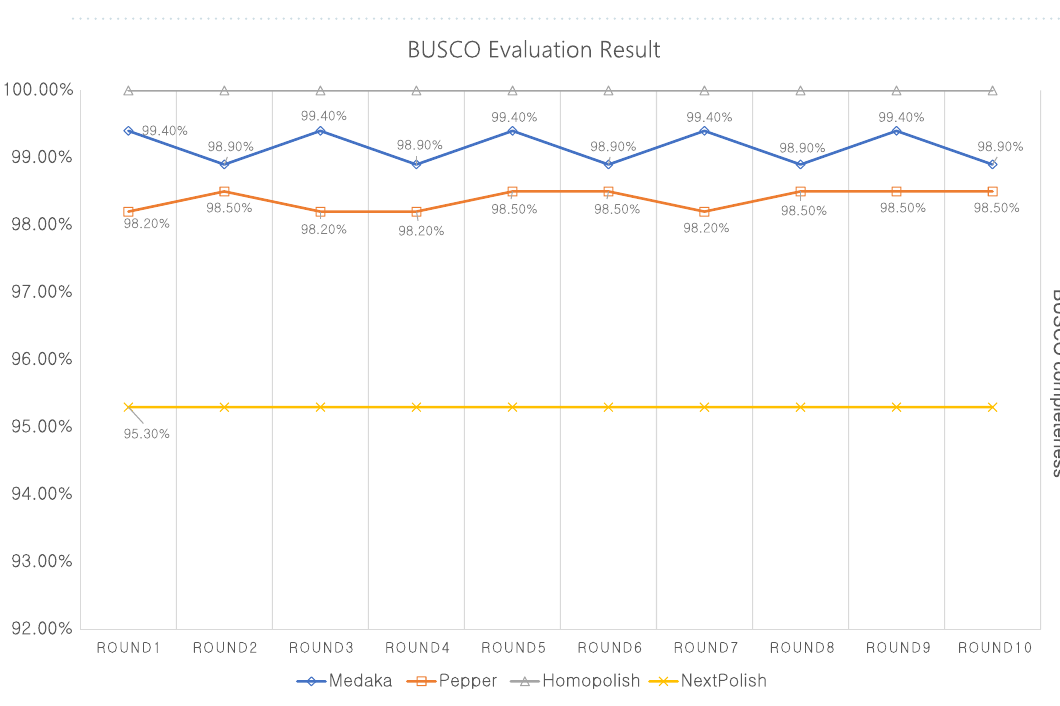
Figure 2. BUSCO evaluation result of 10 round iterative polishing for 4 polishing